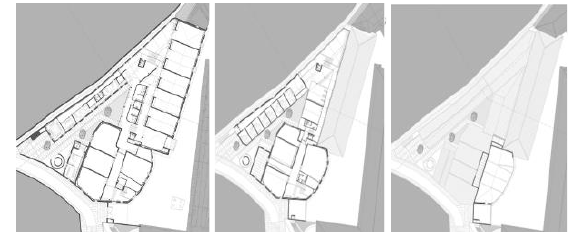
Figure 16. Architectural plans floor 1, 2 and 3 - occupied area for each floor and the increase of levels in the new proposal. Source: Revista Arquitectura & Vida 01-02-2007, pp 37-38.